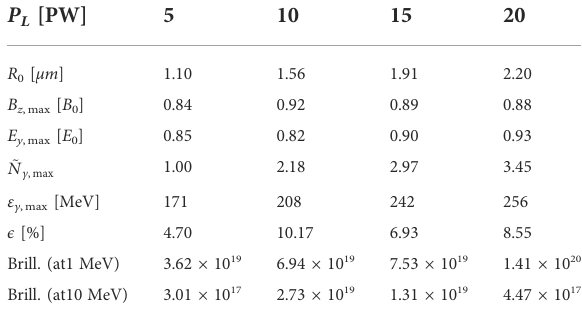
TABLE 3 Table of quantities for a conical target with a 0 =350 and the laser pulse duration τ =20